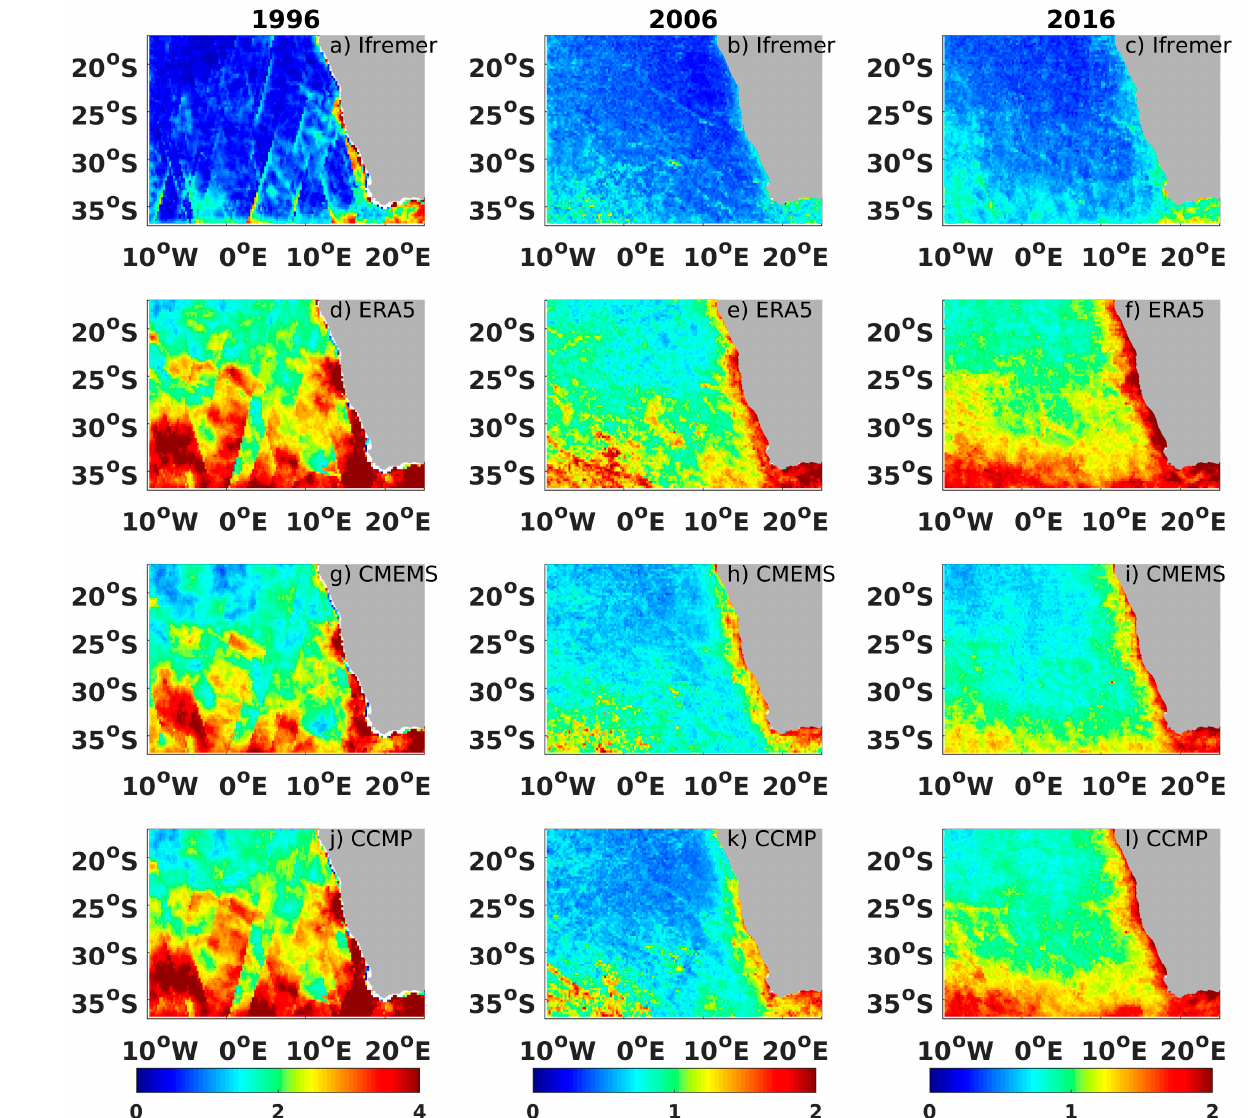
Figure 7. The same as in Figure 6 but for the Benguela upwelling